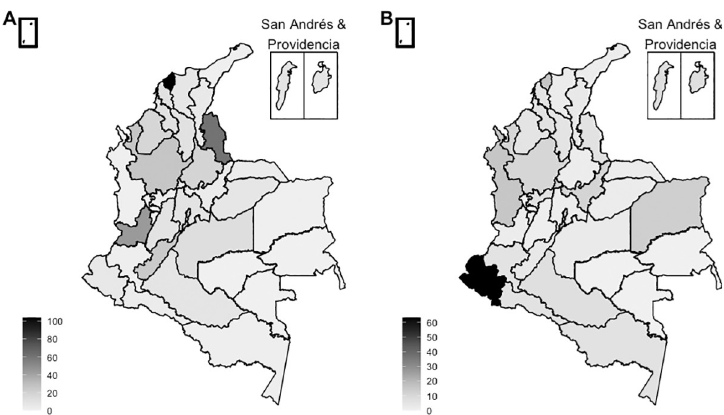
Fig 6. Maps of ZIKV-associated neurological complications by department in Colombia. (A) Number of cases. N = 406 observations with non-missing location at department level. (B) Cumulative incidence of ZIKV-associated neurological complications per 1,000 ZVD cases. Maps were created with shapefiles from the Humanitarian Data Exchange [32]. The shapefiles were prepared by OCHA and are available under a CC BY-IGO license [33]. No changes were made to the shapefiles.